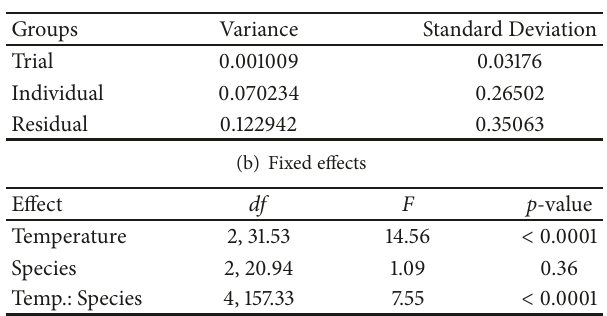
Table 2: Results of the linear mixed model with log-transformed righting time as the response using the function lmer of the R package lmerTest (fit by REML). The random effects are shown as given by the simple summary of the model. The fixed effects are shown as summarized by the function mixed of the package afex (type3 tests,Kenward-Roger approximation for degrees of freedom) [20]. Number of observations = 216; number of trials = 36; number of individuals =